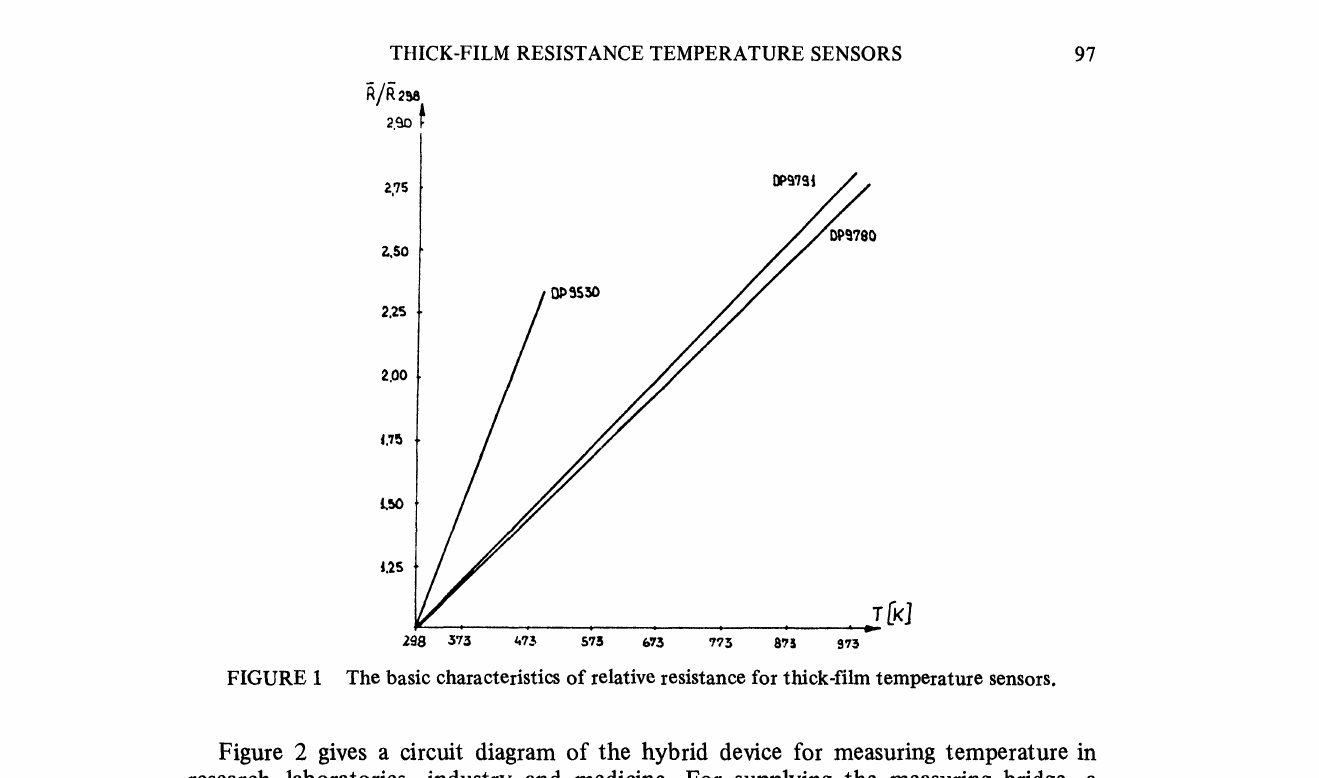
FIGURE 1 The basic characteristics of relative resistance for thick-film temperature sensors.